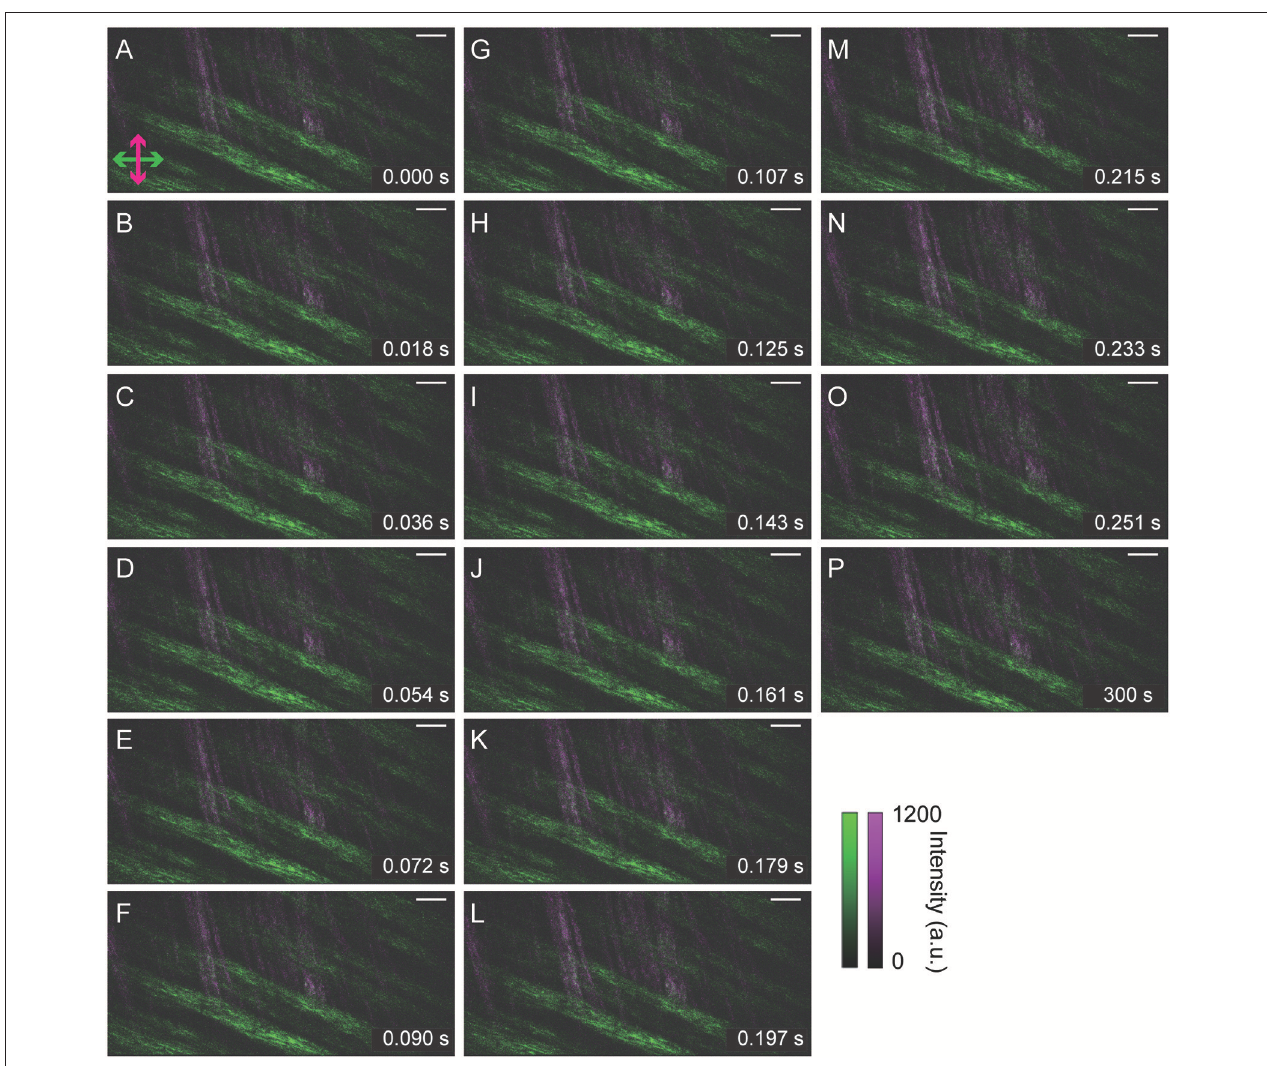
FIGURE 6 | In vivo polarization-resolved SHG images of a mouse skeletal muscle taken 10 µ m from the surface of the living specimen. (A–O) Time series during one cardiac beat. (P) After ∼ 5min measurement. In each image, the exposure time was 18ms, the pixel size was 230nm × 230nm, and the FOV size was 118 µ m × 56 µ m (512 pixels × 244 pixels). Scale bars indicate 10 µ m